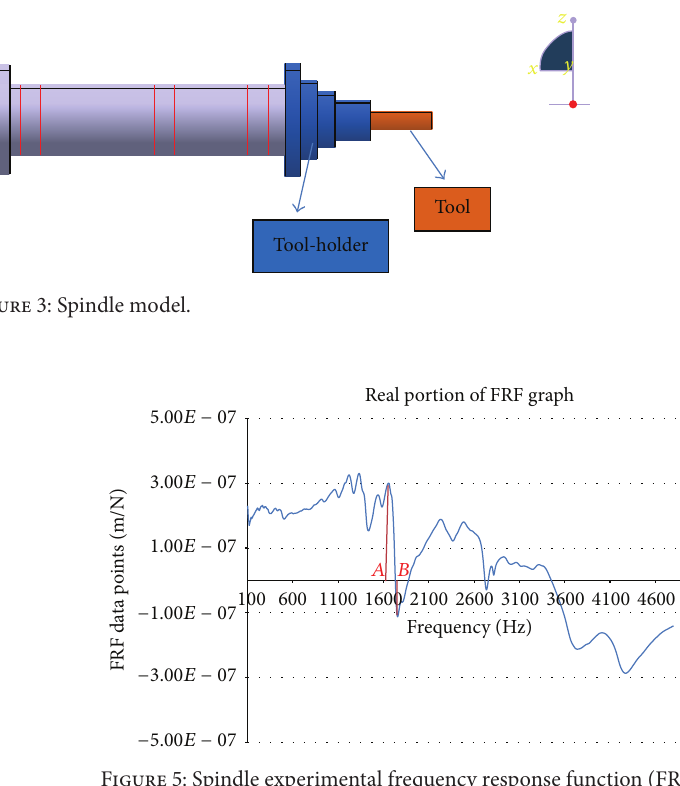
Figure 5: Spindle experimental frequency response function (FRF) (real part).